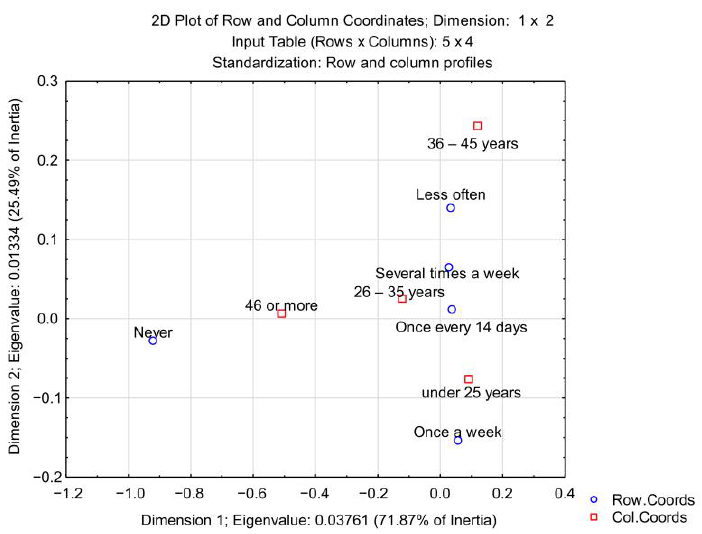
Figure 3. Correspondence maps, Hypermarkets & Respondent’s age. Source: authors.